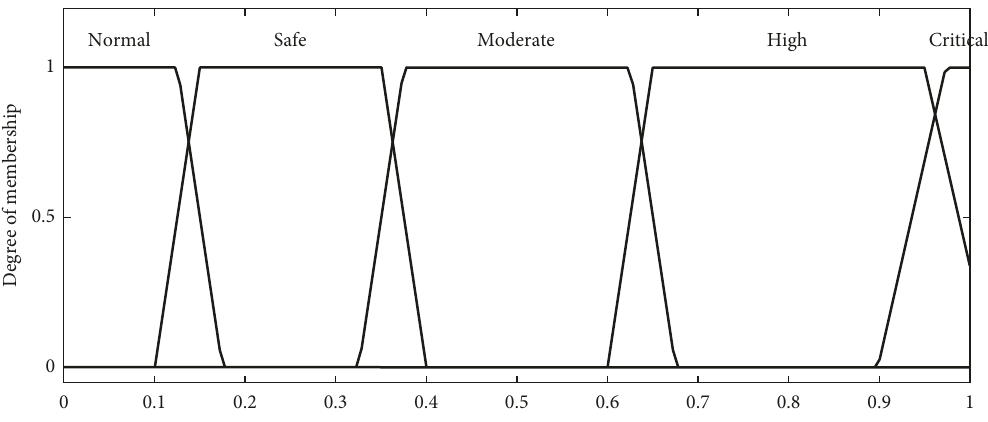
Figure 5: Input variable MF-electrical fault.